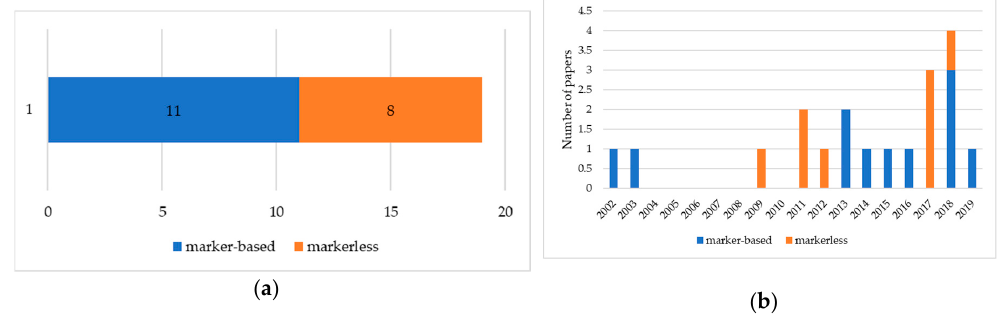
Figure 16. Percentage of AR tracking methods ( a ) and distribution of papers according to tracking method per year ( b ).